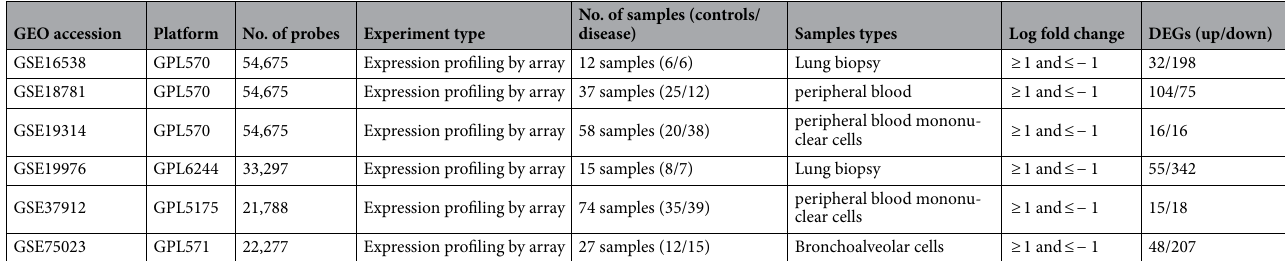
Table 1. Detailed information on the Gene expression microarray datasets related to